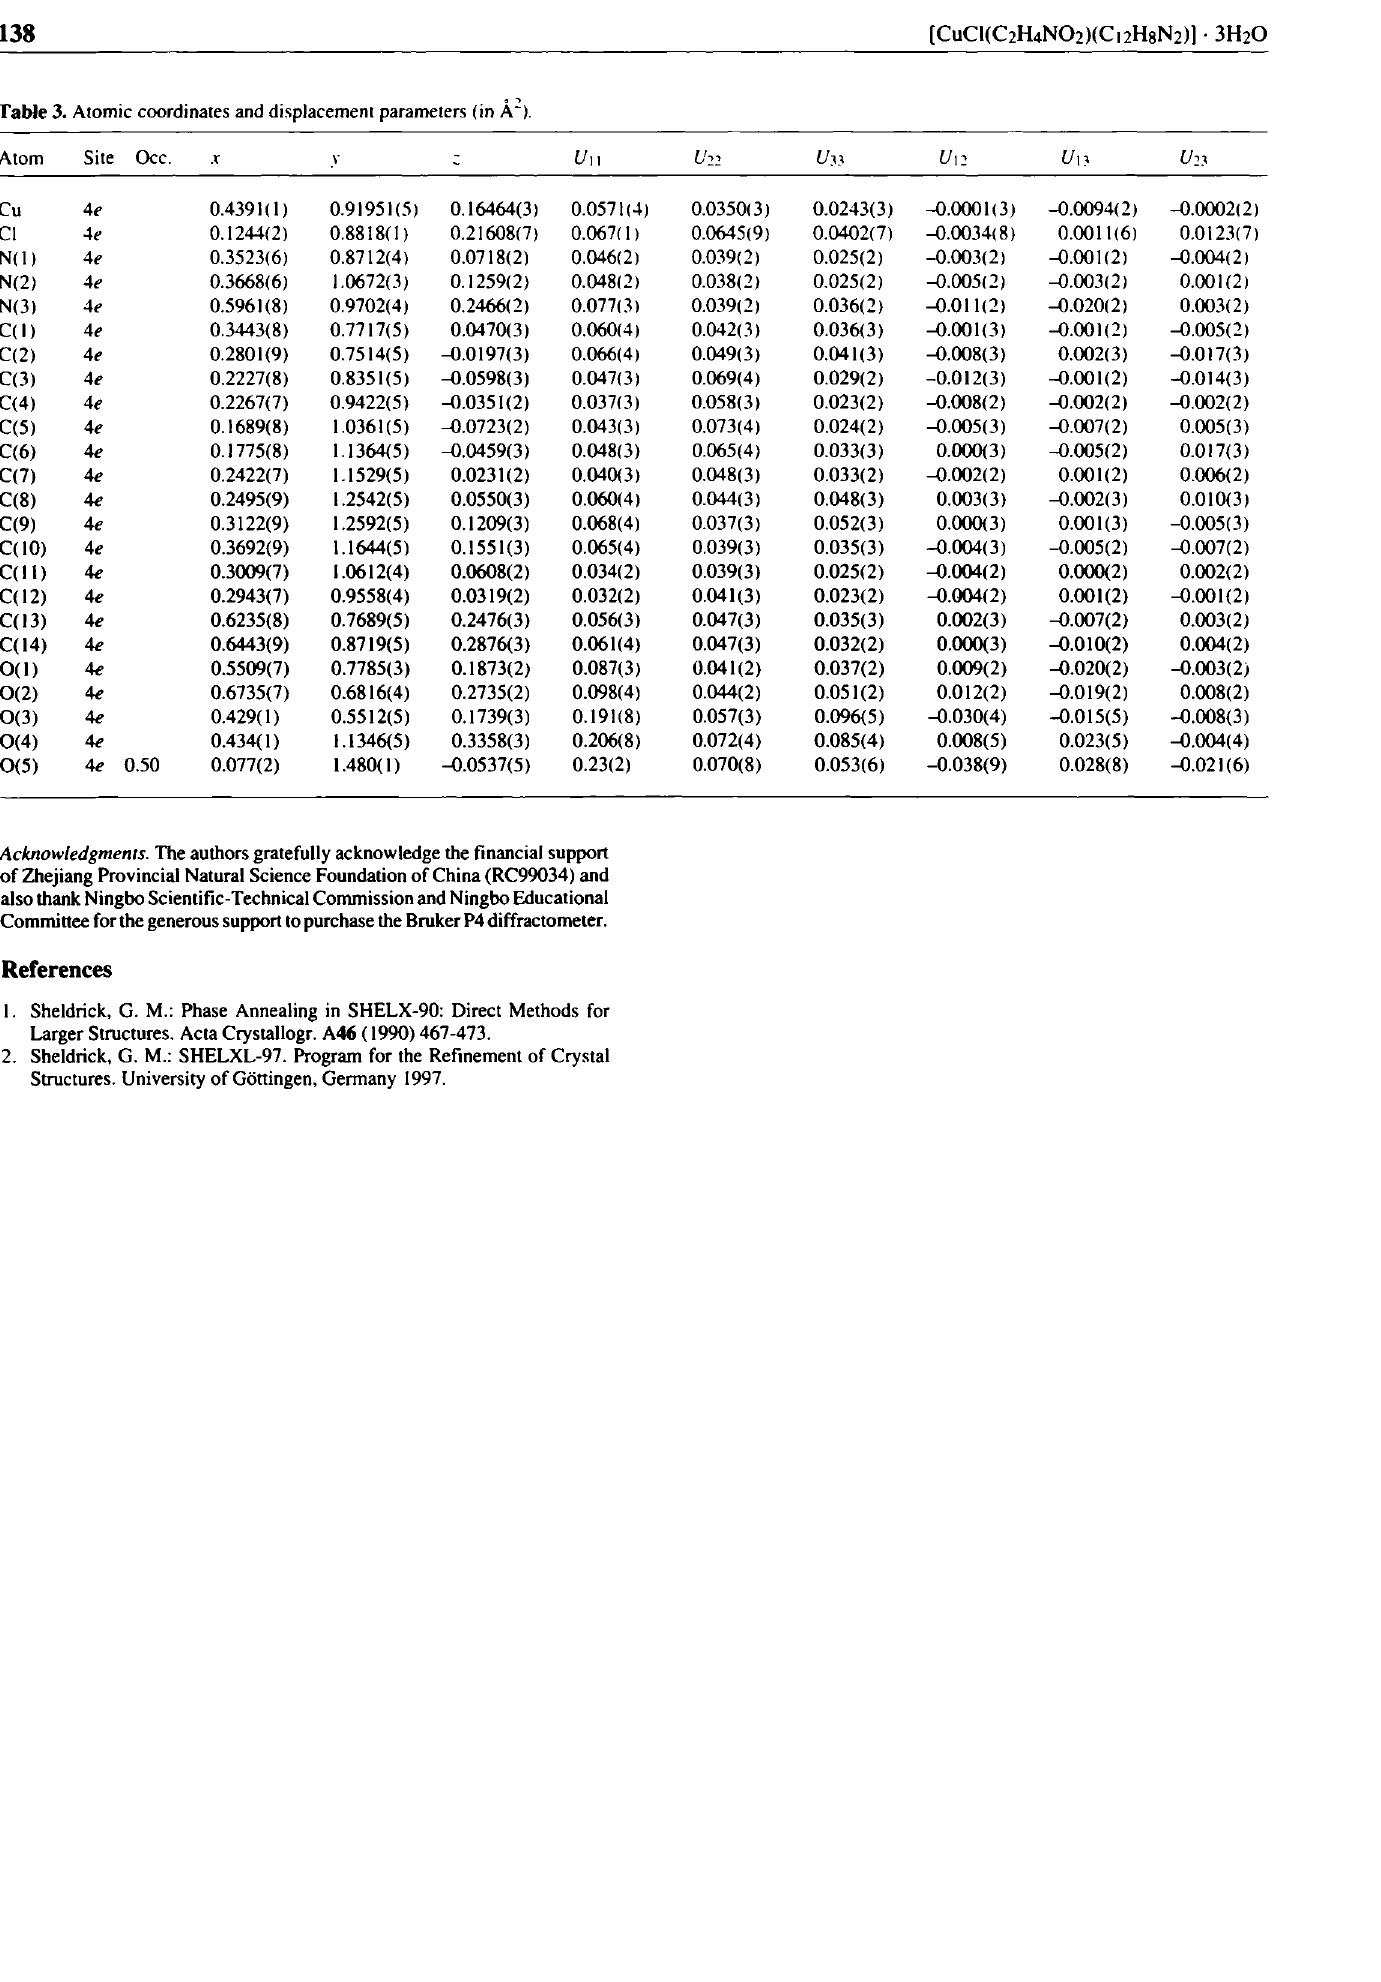
Table 3. Atomic coordinates and displacement parameters (in